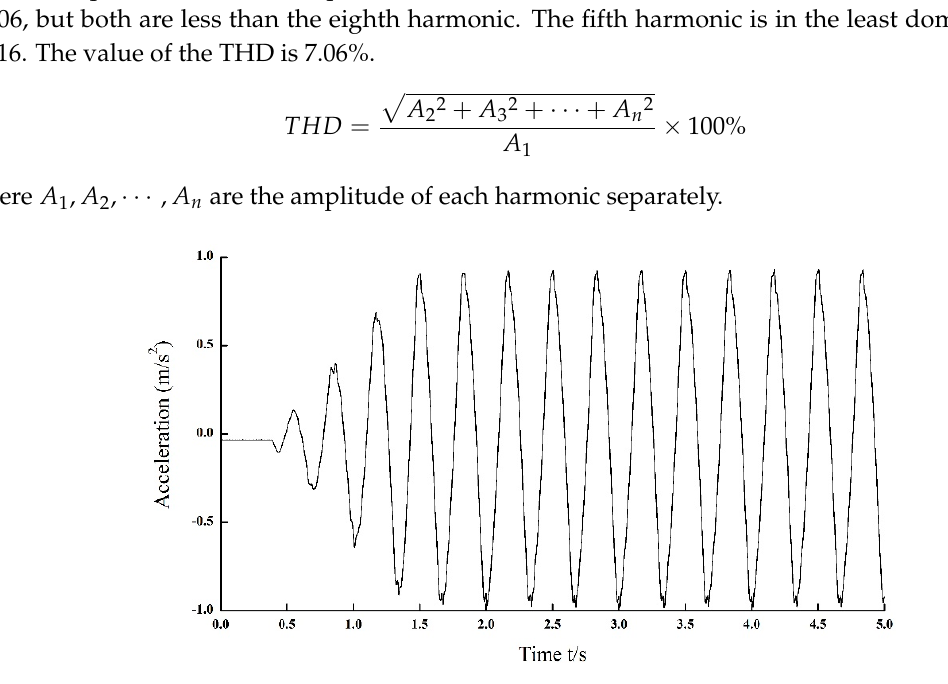
Figure 2. Acceleration response of sin(2 π × 3 t ) m/s 2 in time domain.